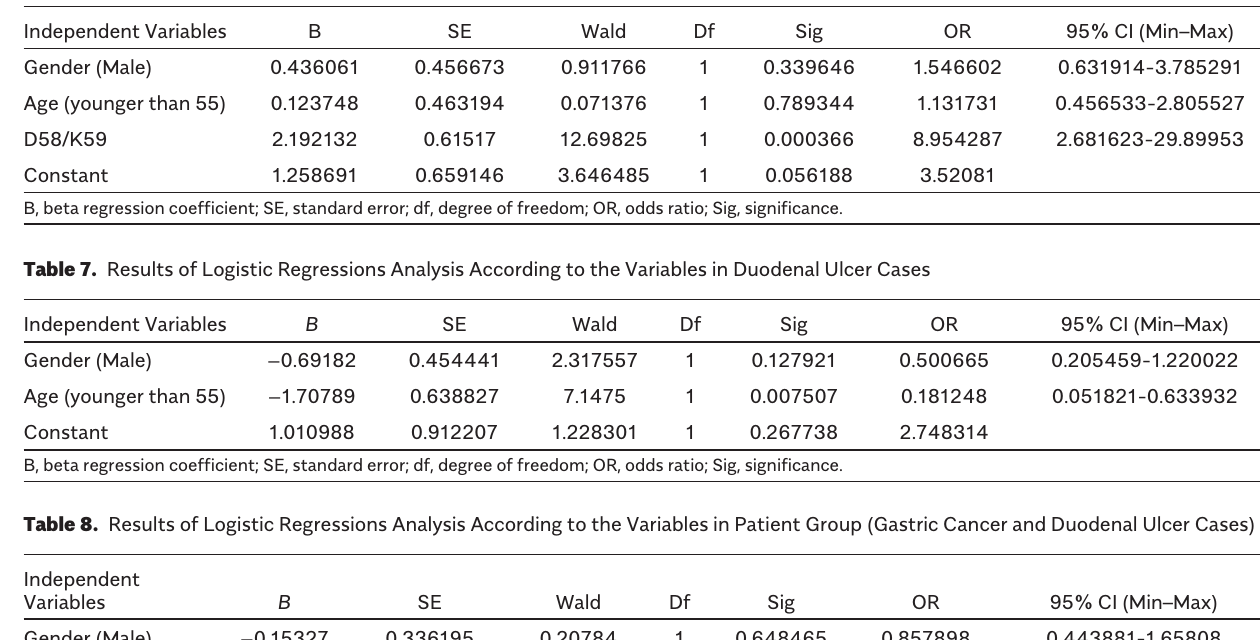
Table 6. Results of Logistic Regressions Analysis According to the Variables in Gastric Cancer Cases Independent Variables B SE Wald Gender (Male)